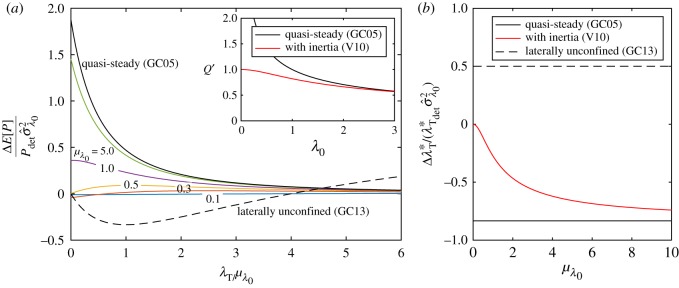
Relative change in expected power per unit relative variance in background friction σ^λ02 as a function of turbine drag scaled with mean background friction at different values of μλ0 (a) and relative change in optimal turbine friction in the presence of uncertainty in the background friction parameter (b) for a fully spanned tidal channel (GC05 and V10). In panel (a), for the GC05 model (black line) the lines from figure 2 reduce to the same curve upon scaling. The inset shows the non-dimensional flow rate Q′ = ωc/(ga)Q as a function of channel friction parameter λ0 for an undisturbed channel, i.e. λT = 0.